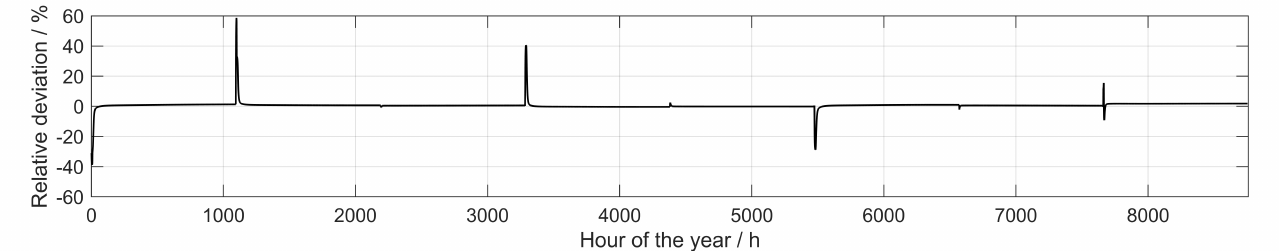
Figure 9. Relative deviation between the simulated mean outlet temperatures concerning the temperature calculated with FEFLOW .